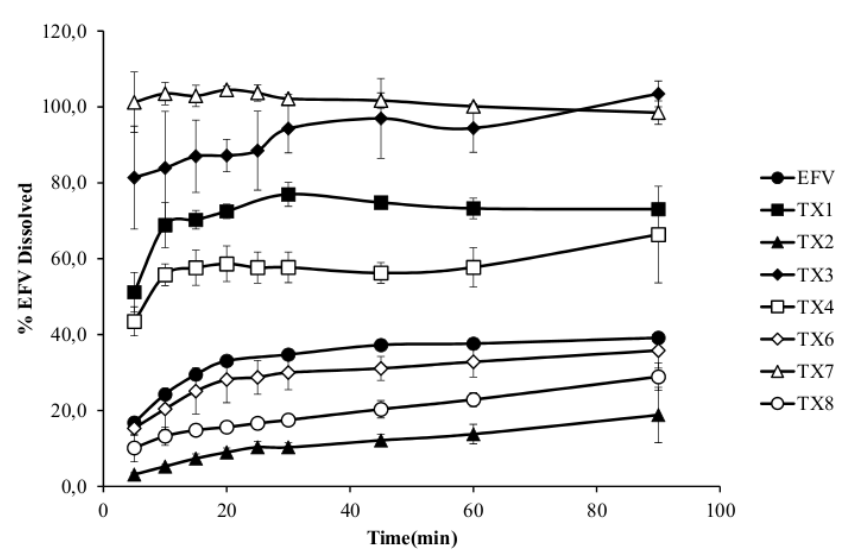
FIGURE 5 - Dissolution profiles of